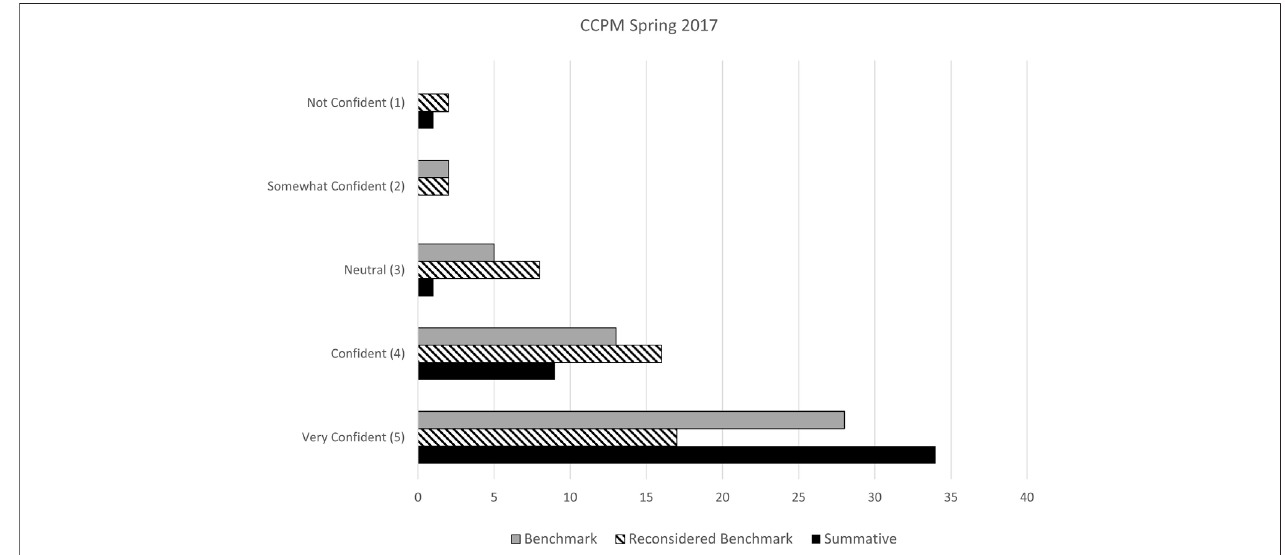
FIGURE 1 | CCPM Spring 2017 Cohort Survey